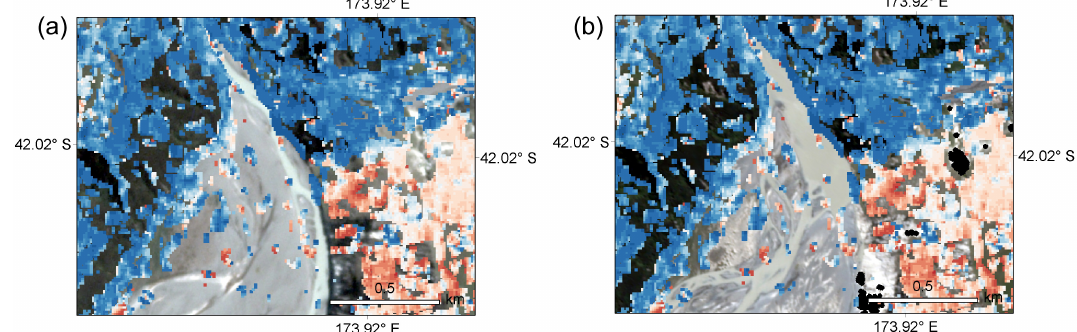
Figure 7. Horizontal surface displacements from PlanetScope images of 27 October–21 November 2016, W–E component. Background: PlanetScope images of 27 October (a) and 21 November (b) . Clarence River was dammed up by the rupture and its course was diverted. Location: rectangle E of Fig. 4.